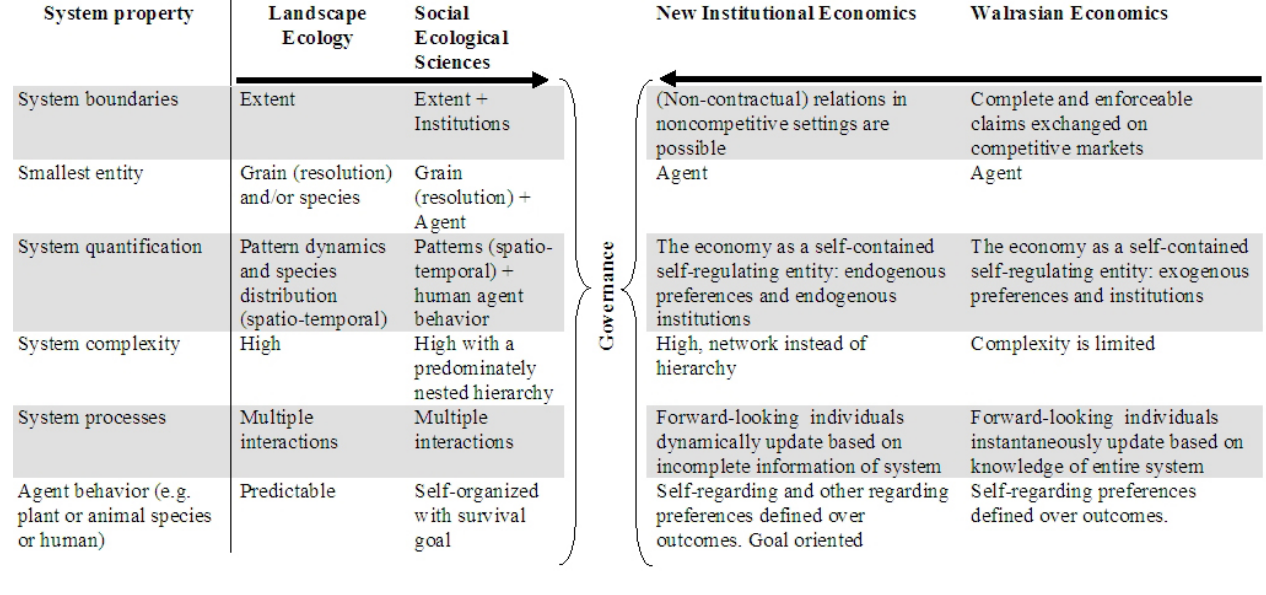
Fig. 1. Comparison of the different system properties between ecological sciences and economic